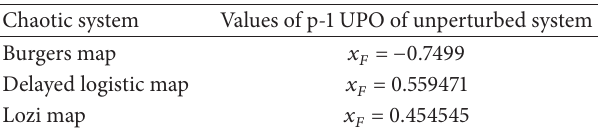
Table 3: The values for p-1 UPO.